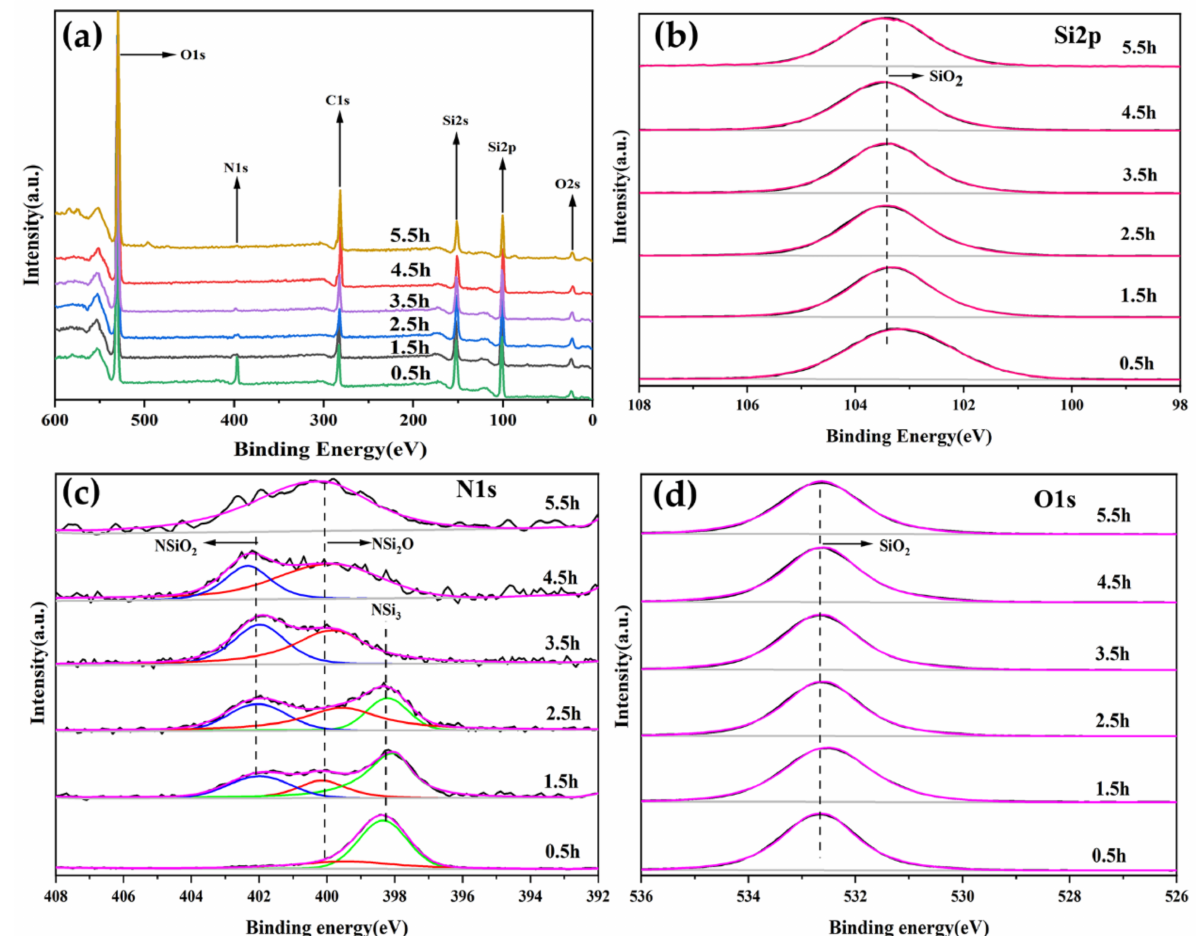
Figure 2. X − ray photoelectron spectroscopy XPS spectra of the ( a ) wide − scan, ( b ) O (1s), ( c ) N (1s), and ( d ) Si (2p) peak transitions from PHPS coatings as a function of pyrolysis time. Table 1. The fraction (f) of nitrogen and oxygen atoms involved in different bonds as